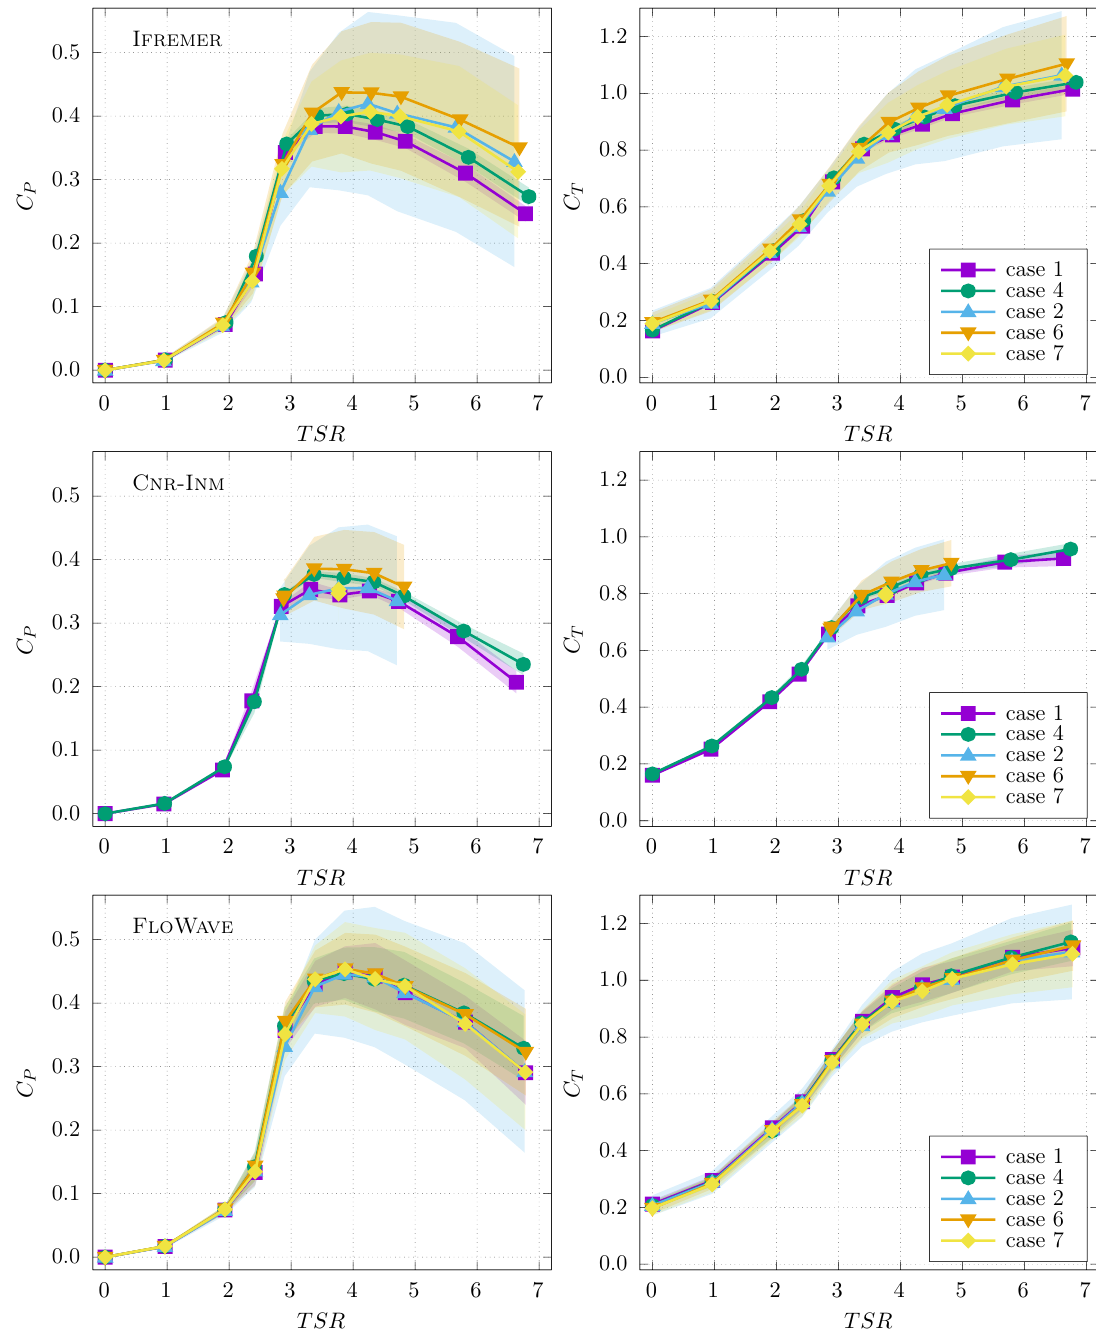
Figure A1. Power ( left ) and thrust ( right ) coefficients comparison for the same test cases than Figures 14 and 15: 1 current-only at 0.8 m/s, 4 current-only at 1.0 m/s, 2 regular wave with 0.8 m/s, 6 regular wave with 1.0 m/s and 7 irregular wave with 0.8 m/s, versus TSR and displayed within an individual test